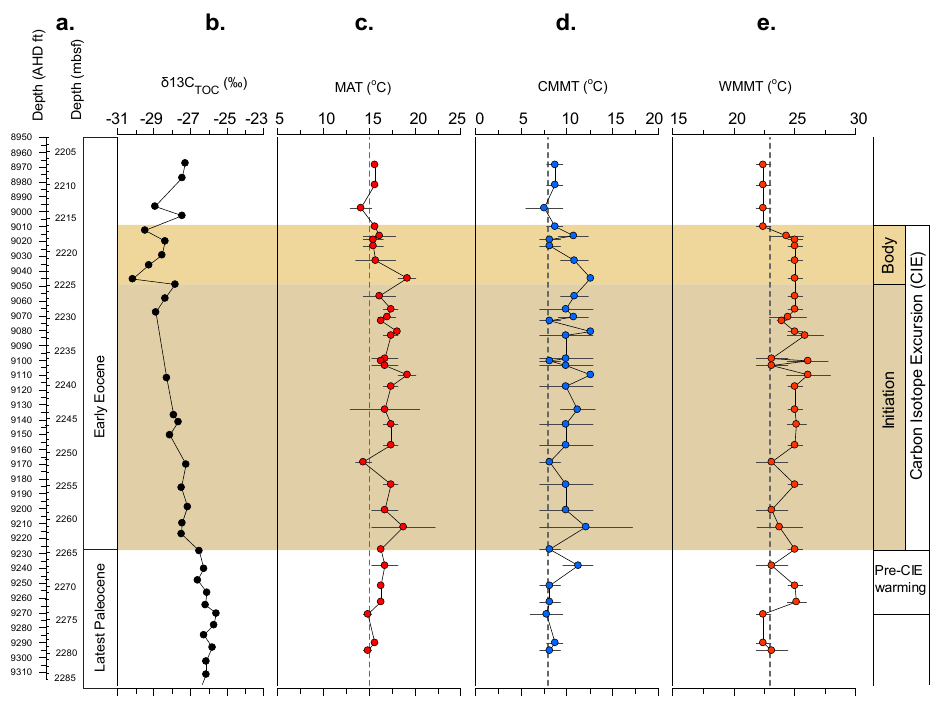
Fig. 4. Record of Paleocene–Eocene temperature data from well 22/11-N1: (a) depth and age, (b) carbon isotope data ( δ 13 C TOC ) , (c) MAT, (d) CMMT, and (e) WMMT. (c–e) Horizontal bars and shaded area represent the minimum and maximum estimate returned from the method.